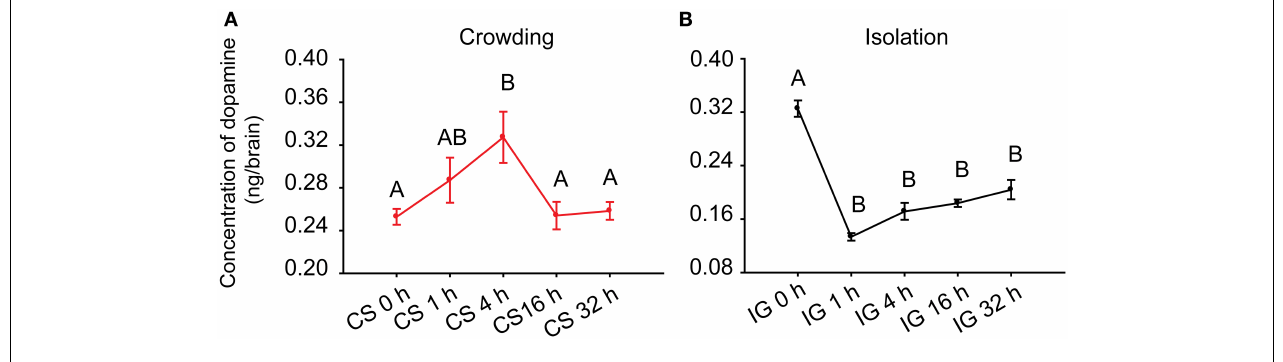
isolation. Dopamine levels in crowding and isolation were analyzed by One-Way ANOVA, followed by post-hoc Tukey test for multiple comparisons ( n = 8 for each point, P < 0 . 05 ). Abbreviations: DA, dopamine; CS, crowding of solitary locusts; IG, isolation of gregarious locusts.